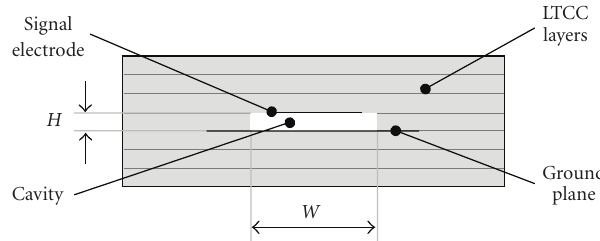
Figure 4: Cross-section of an LTCC-based inverted microstrip